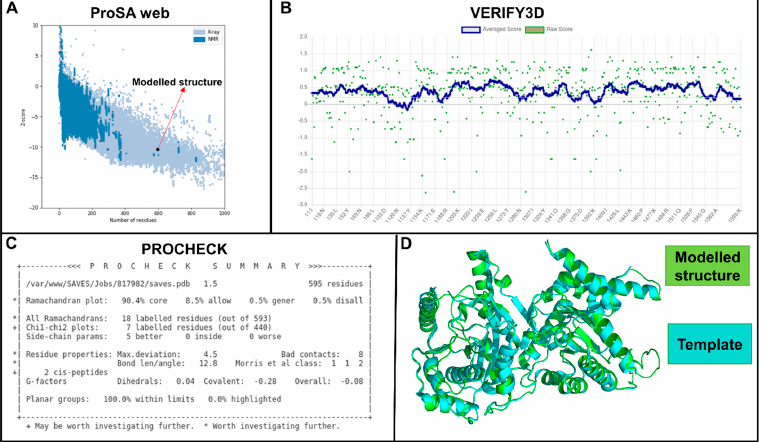
Figure 2. Evaluation scores of the modeled structures of WT Pf dhps for evaluation, performed via ProSA, Verify3D, PROCHECK, and PDB metrics. ( A ) ProSA results, showing that the modeled structure is comparable to X-ray structures of a similar size; ( B ) Verify3D data, indicating that all classified residues (alpha, beta, loop, polar, nonpolar etc.) are within the accepted window and environment; ( C ) Ramachandran plot by PROCHECK, showing that > 90% of residues have the correct stereochemical structure; and ( D ) a superimposed image of the modeled and template structures (RMSD = 0.19 Å).